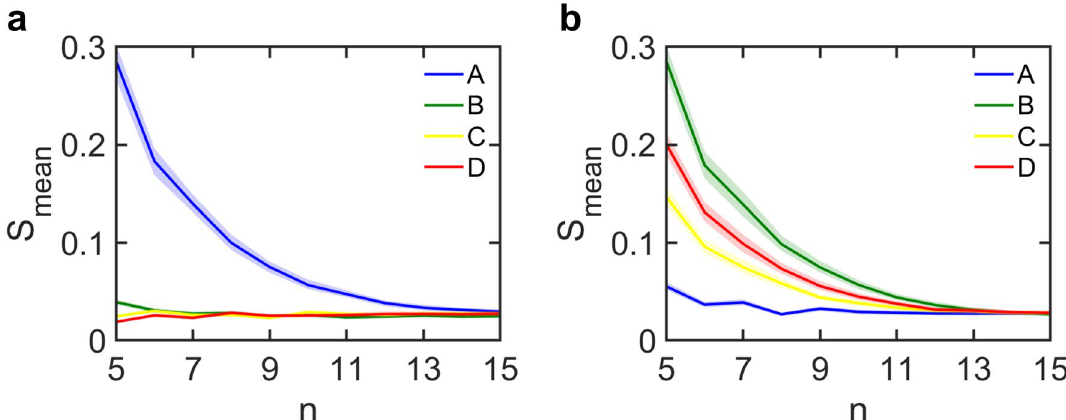
Figure 6. Improving system security against sophisticated attack. Variation of mean score S mean with n calculated with respect to letters ‘A’ through ‘D’ for encrypted letter ( a) ‘A’ and ( b) ‘B’. Solid lines indicate average S mean over 1000 trails with 1000 keys each, and colored bands represent the corresponding error bounds.